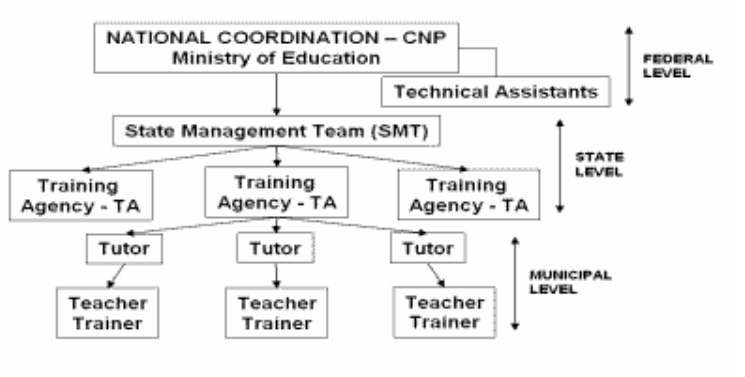
Figure 1 . Proformação Organizational